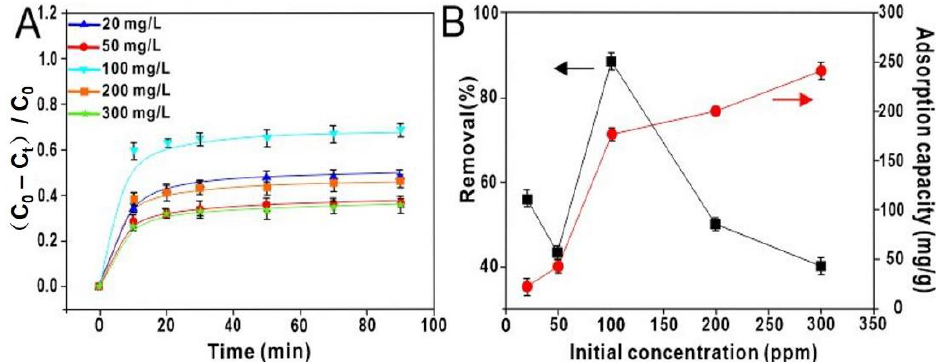
Figure 7. The effect of initial concentration on Zn 2+ adsorption under a pH of 13.0 at 25 °C ( A ). Adsorption capacity and removal of Zn 2+ on MnO 2 @PSS/PDDA/PSS, with different initial Zn 2+ concentrations at 25 °C ( B ).